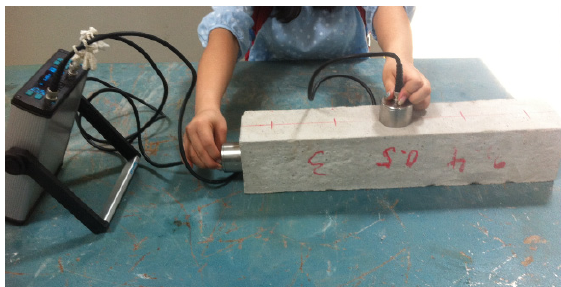
Figure 5. Semi-direct UPV measurement.